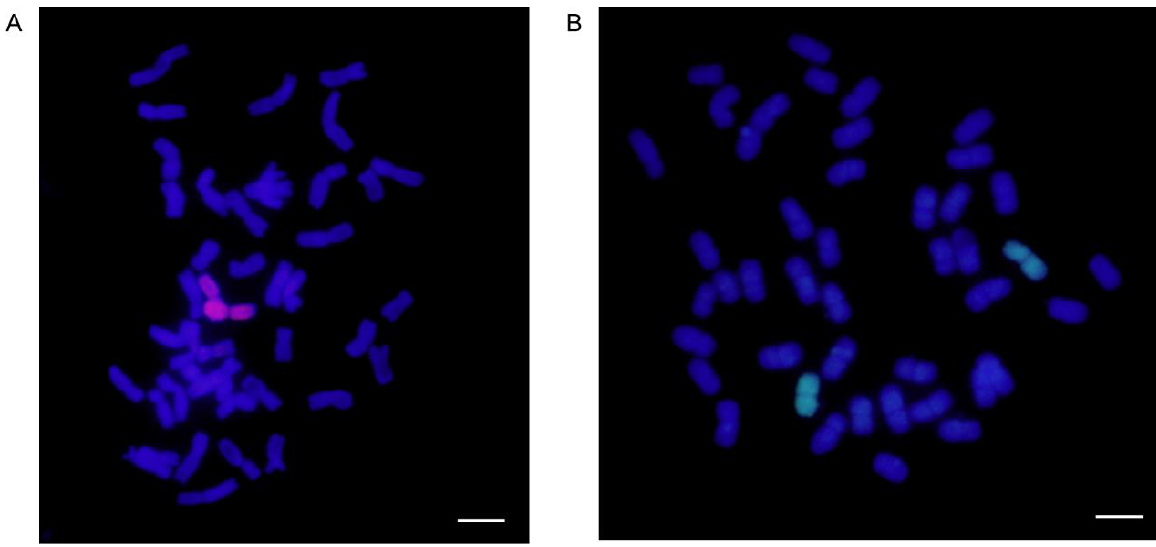
Figure 1. GISH results of wheat– A. cristatum 6P addition lines. ( A ) GISH of 5113; ( B ) GISH of II-30-5. The A. cristatum chromosomes are in red or green, while the wheat chromosomes are in blue. Scale bar, 10 μm.